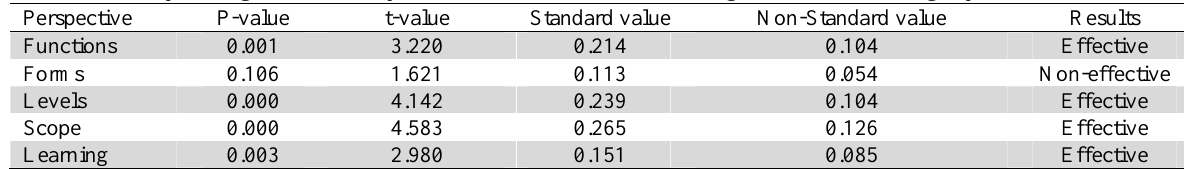
The summary of regression analysis between emotional intelligence and thinking